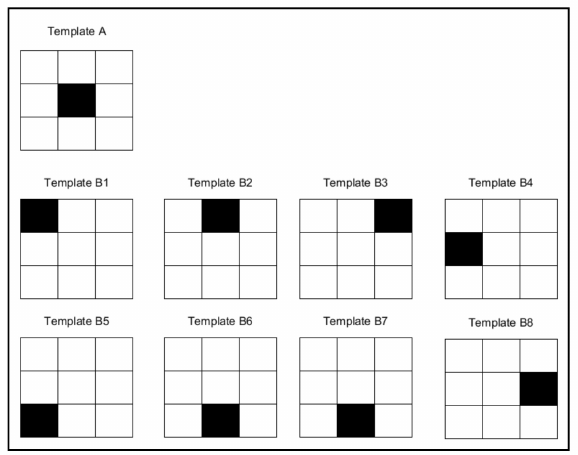
Figure 10. The distance of template “A” from the eight di ff erent templates for “B” is the same: the number of ink and non-ink matches is